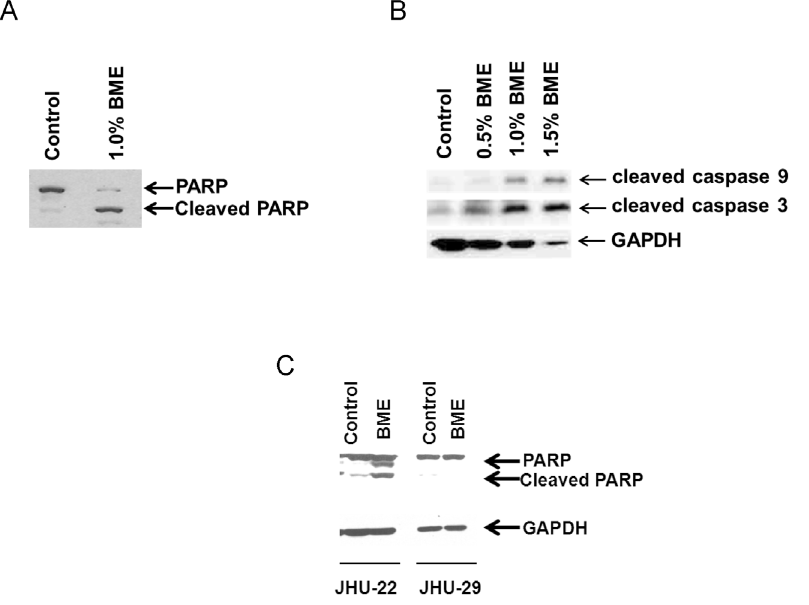
Figure 2. BME treatment in HNSCC cells induced PARP cleavage and caspase activation. (A). Lysates were prepared from Cal27 cells treated or untreated with BME for 72 h, and subjected to Western blot analysis using a specific antibody to PARP. Following treatment of BME, PARP was cleaved to an 86 kD signature peptide. (B). Treatment of Cal27 cells with BME induced caspase 9 and 3 cleavage. The cleaved product of caspase 9 and caspase 3 are shown. The blot was reprobed with an antibody to GAPDH for comparison of equal protein load. (C). JHU-22 and JHU-29 cells were treated with BME and cell lysates were subjected to Western blot analysis for PARP cleavage using specific antibody. The blot was reprobed with an antibody to GAPDH for comparison of equal protein load.